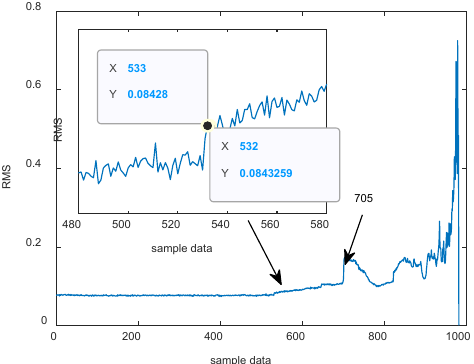
Figure 13. RMS of original vibration signals.